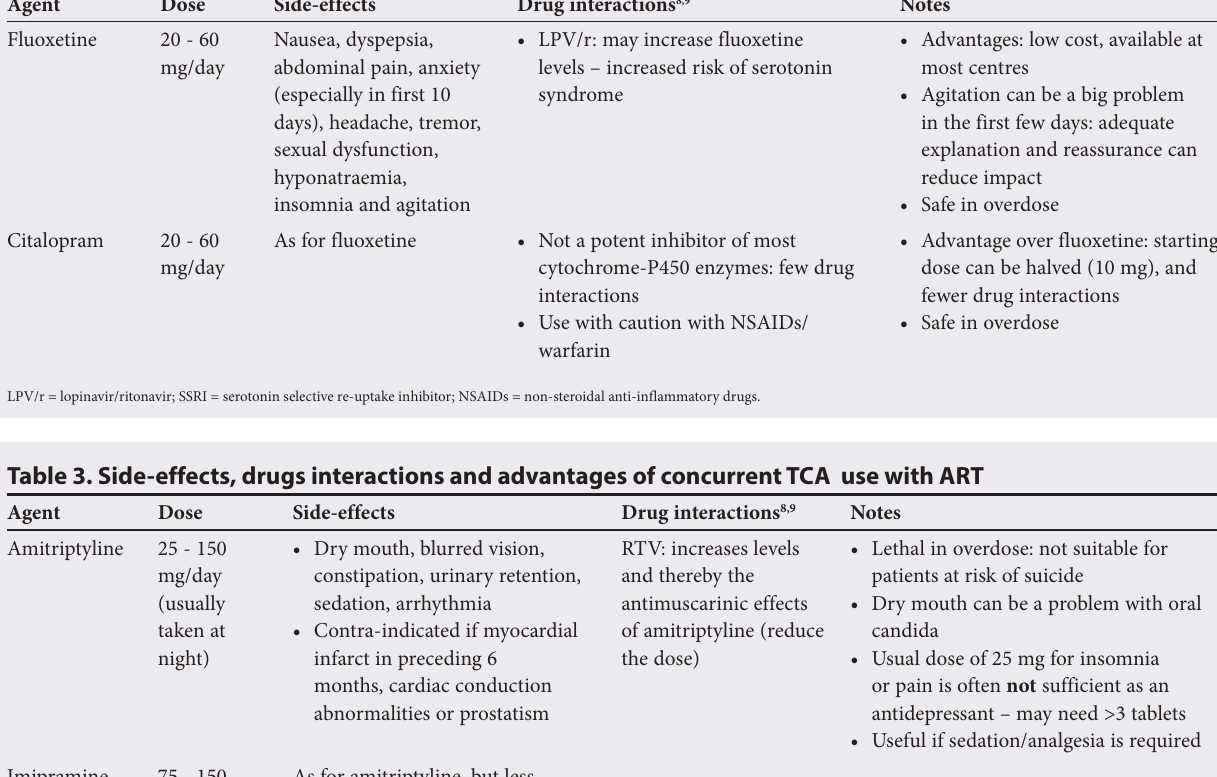
Table 2. Side-effects, drug interactions and advantages of concurrent SSRI use with ART Agent